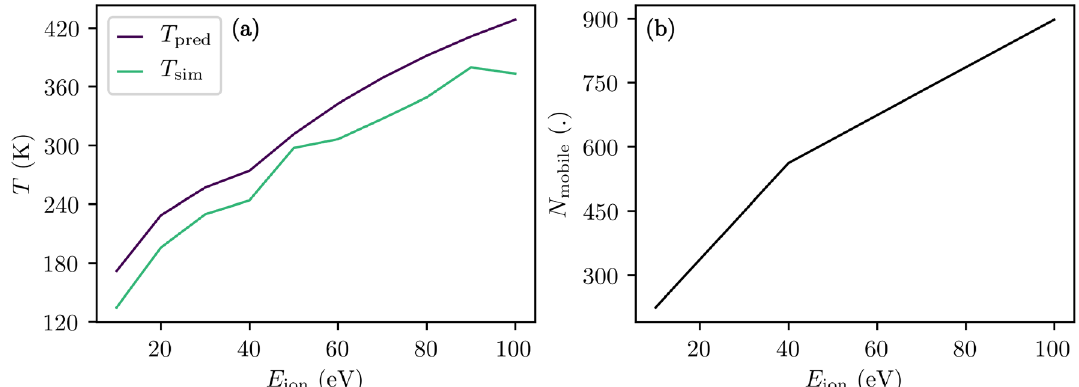
Figure 5. ( a ) Theoretically predicted (see Eq. (3)) and simulated surface slab temperatures T pred and T sim as well as ( b ) number of simulated mobile atoms N mobile are presented as function of the ion energy E ion